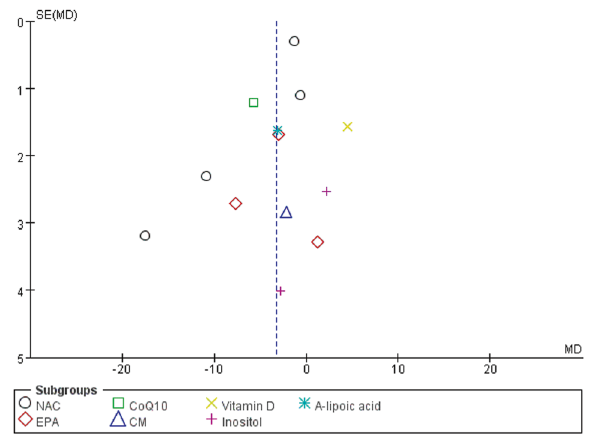
Fig. 2 Funnel plot for publication bias. Begg ’ s funnel plot for publication bias analysis.